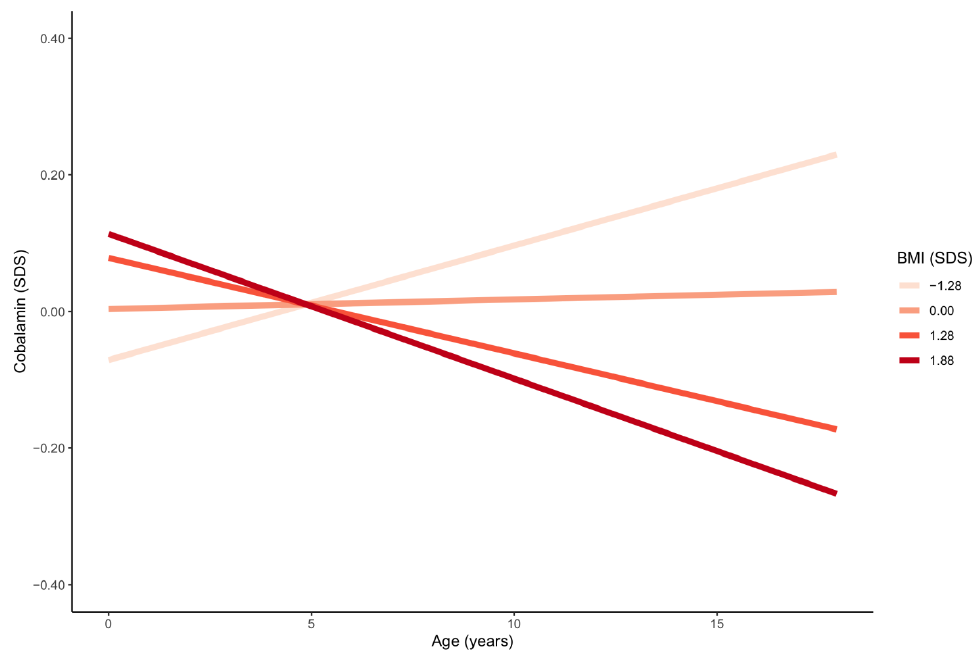
Figure 3. Age trends in serum cobalamin for four different values of BMI-SDS. BMI-SDS groups: underweight: BMI-SDS < −1.28; normal weight: BMI-SDS −1.28 to < 1.28; overweight: BMI-SDS > 1.28 to 1.88; obese: BMI-SDS >1.88. SDS = standard deviation score; BMI-SDS = body mass index standard deviation score.